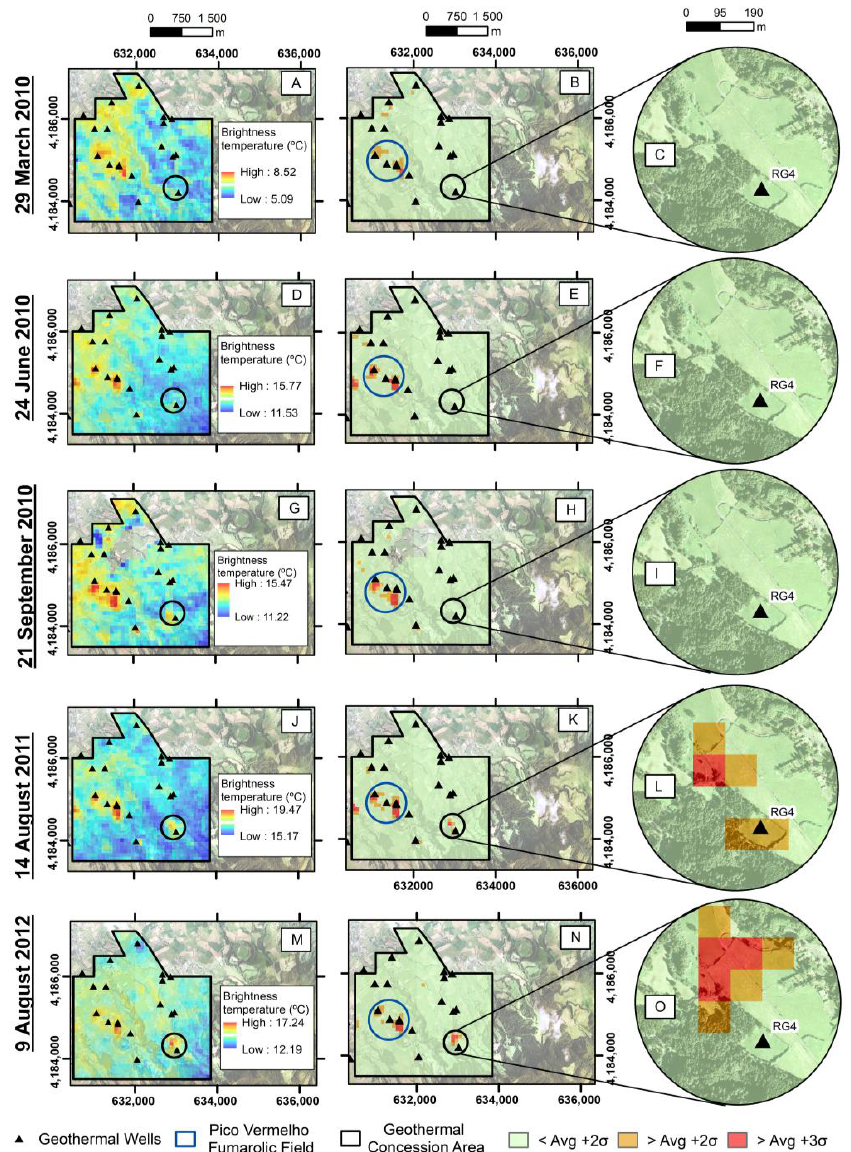
Figure 4. Part of the Geothermal Concession Area: ( A ) the ASTER nighttime thermal infrared image from 29 March 2010, ( B ) normal temperatures (below average temperature + 2 σ ) presented in green, above average temperatures + 2 σ in orange, and above average + 3 σ in red, and ( C ) framing of the area near the RG4 well, where it was not possible to identify thermal anomalies; ( D ) the ASTER nighttime thermal infrared image from 24 June 2010, ( E ) normal temperatures presented in green, above average temperatures + 2σ in orange, and above average + 3σ in red, and ( F ) framing of the area near the RG4 well, where it was not possible to identify thermal anomalies; ( G ) the ASTER nighttime thermal infrared image from 21 September 2010, ( H ) normal temperatures presented in green, above average temperatures + 2σ in orange, and above average + 3σ in red, and ( I ) framing of the area near the RG4 well, where it was not possible to identify thermal anomalies; ( J ) the ASTER nighttime thermal infrared image from 14 August 2011, ( K ) normal temperatures presented in green, above average temperatures + 2σ in orange, and above average + 3σ in red, and ( L ) framing of the area near the RG4 well, where it was possible to identify thermal anomalies; ( M ) the ASTER nighttime thermal infrared image from 09 August 2012, ( N ) normal temperatures presented in green, above average temperatures + 2 σ in orange, and above average + 3 σ in red, and ( O ) framing of the area near the RG4 well, where it was possible to identify thermal